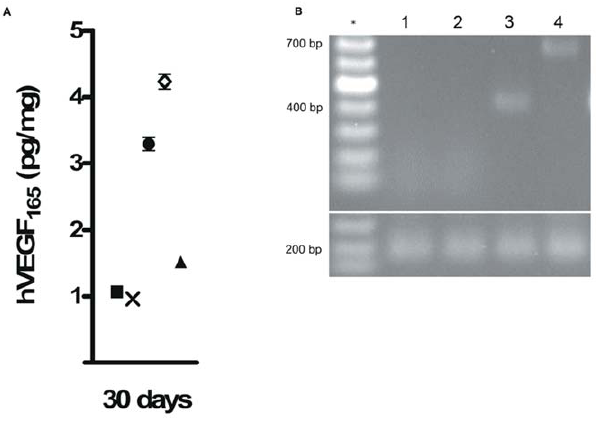
Figure 5. Assessment of VEGF expression vectors after gene N therapy. (A) Concentration of hVEGF 165 in the quadriceps muscle: - x - - pVHAVI; - e - pVAVI. (B) Genomic Ischemic; - & - Normal; - m - pVV; - DNA PCR after four weeks of gene therapy. 1: normal; 2: pVV; 3: pVAVI (432 bp); 4: pVHAVI (725 bp). The 200 bp band is from GAPDH. * 100 bp ladder.